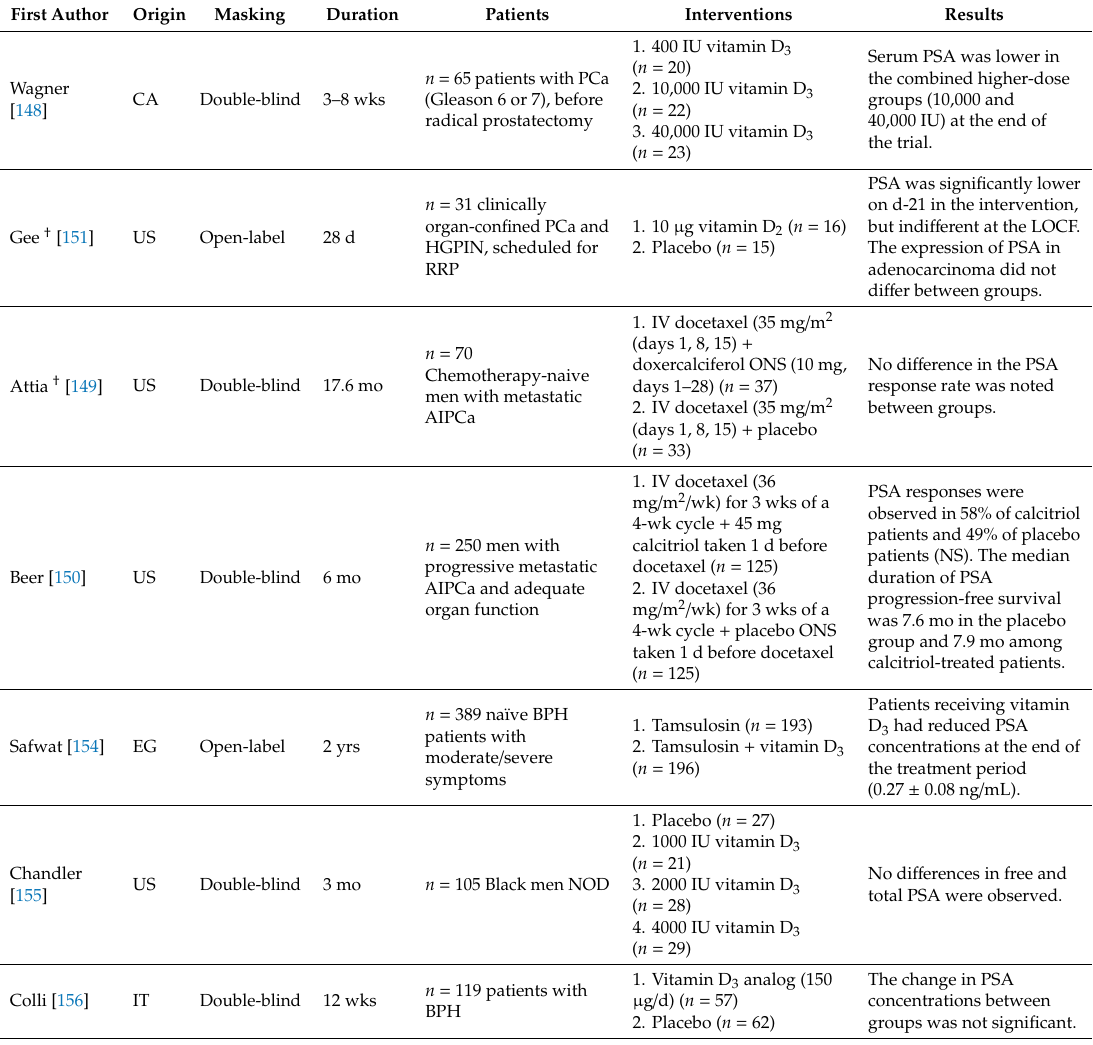
Table 7. RCTs examining the e ff ect of vitamin D ONS on PSA concentrations among men with PCa or increased PCa